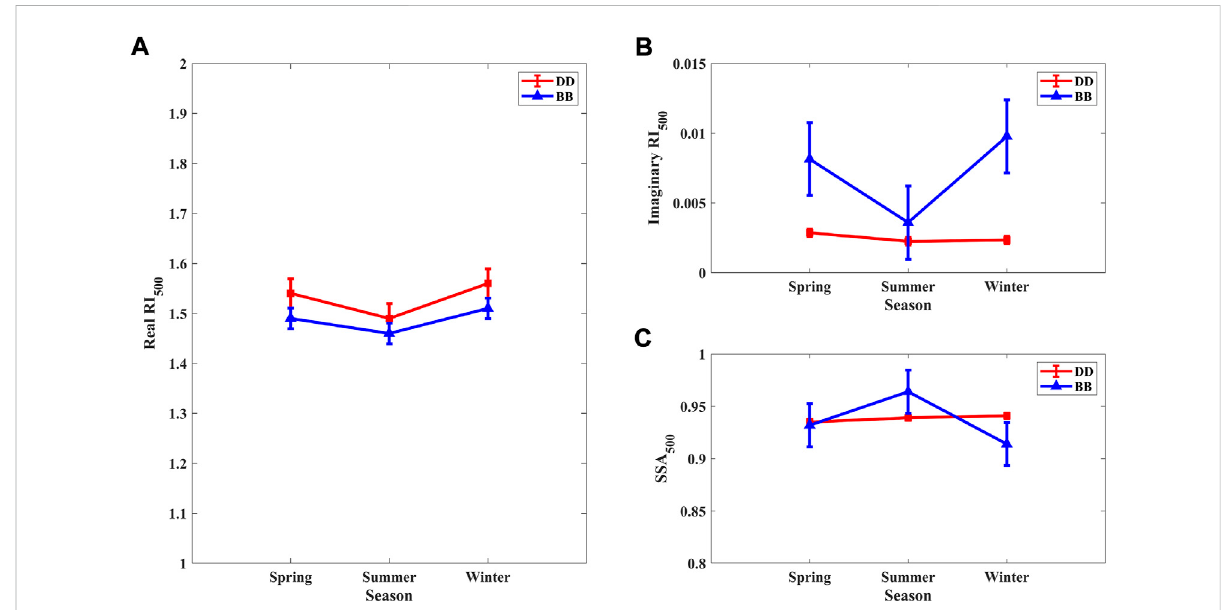
FIGURE 10 Seasonal averages of real RI (A) , imaginary RI (B) , and SSA (C) at 500 nm for BB/UI and DD